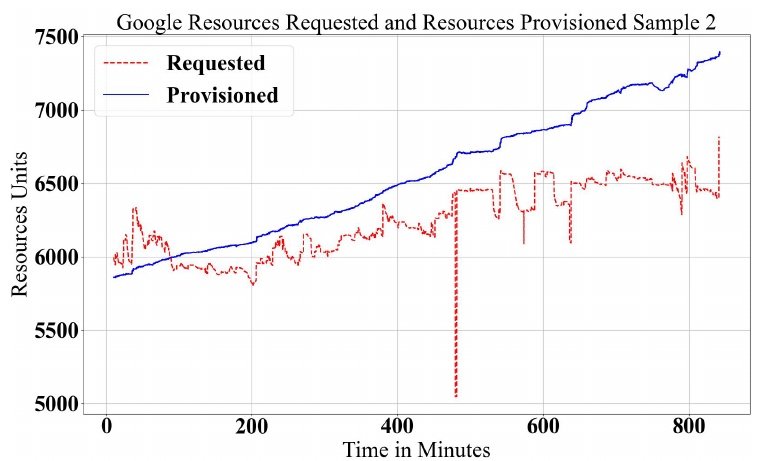
Figure 3. Google data center Provisioned and Requested Workloads, Sample 2.